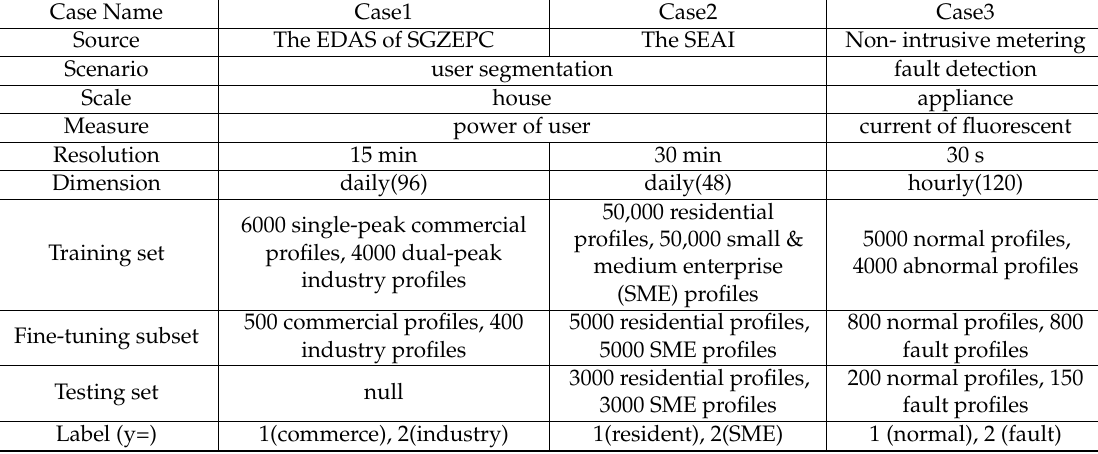
Table 2. Description of the utilized cases.